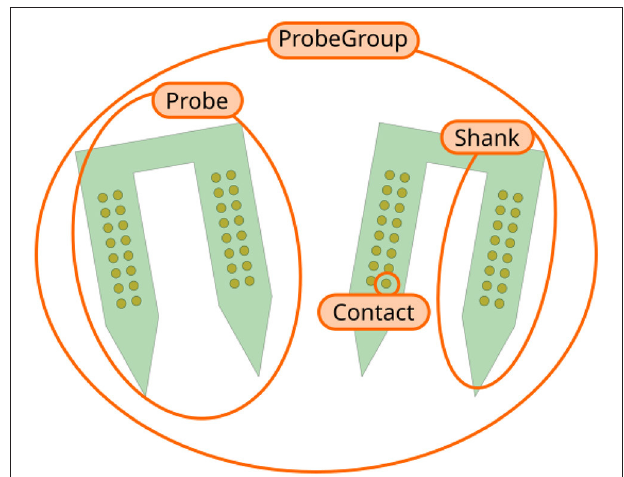
FIGURE 1 | Overview of ProbeInterface objects. Each recording site is a Contact . Several contacts make up a Shank , which is a region of the probe with multiple contacts. A Probe can consist of multiple shanks (two in this figure). Finally, several Probe objects can be combined into a ProbeGroup